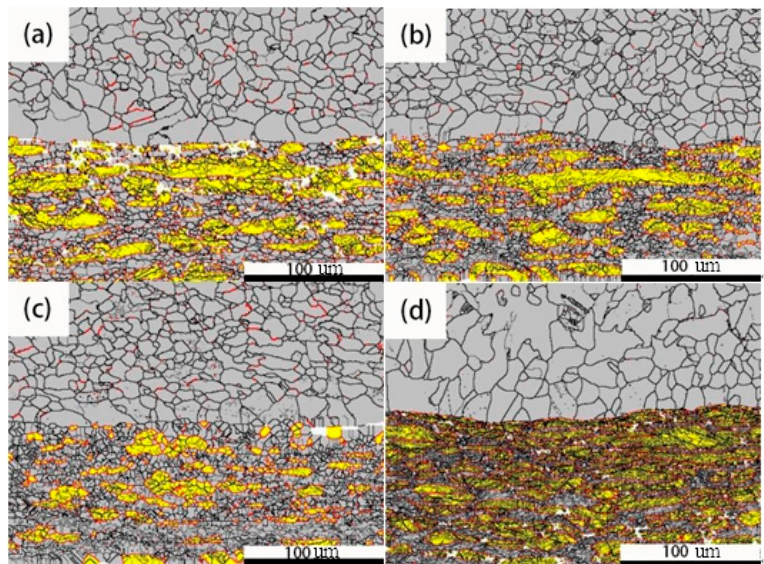
Figure 7. Phase boundary and grain boundary diagrams of large deformation regions at different rates at 850 °C. ( a ) 0.01 s − 1 ; ( b ) 0.1 s − 1 ; ( c ) 1 s − 1 ; ( d ) 10 s − 1